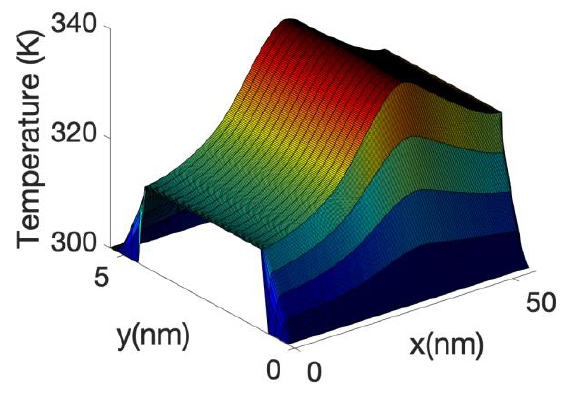
Figure 16. Lattice temperature profile at Vg = 0.7 V, hot electrons and self-heating.